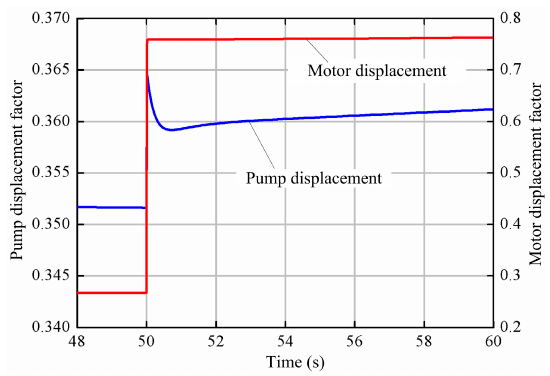
Figure 17. Pump displacement factor and motor displacement factor.